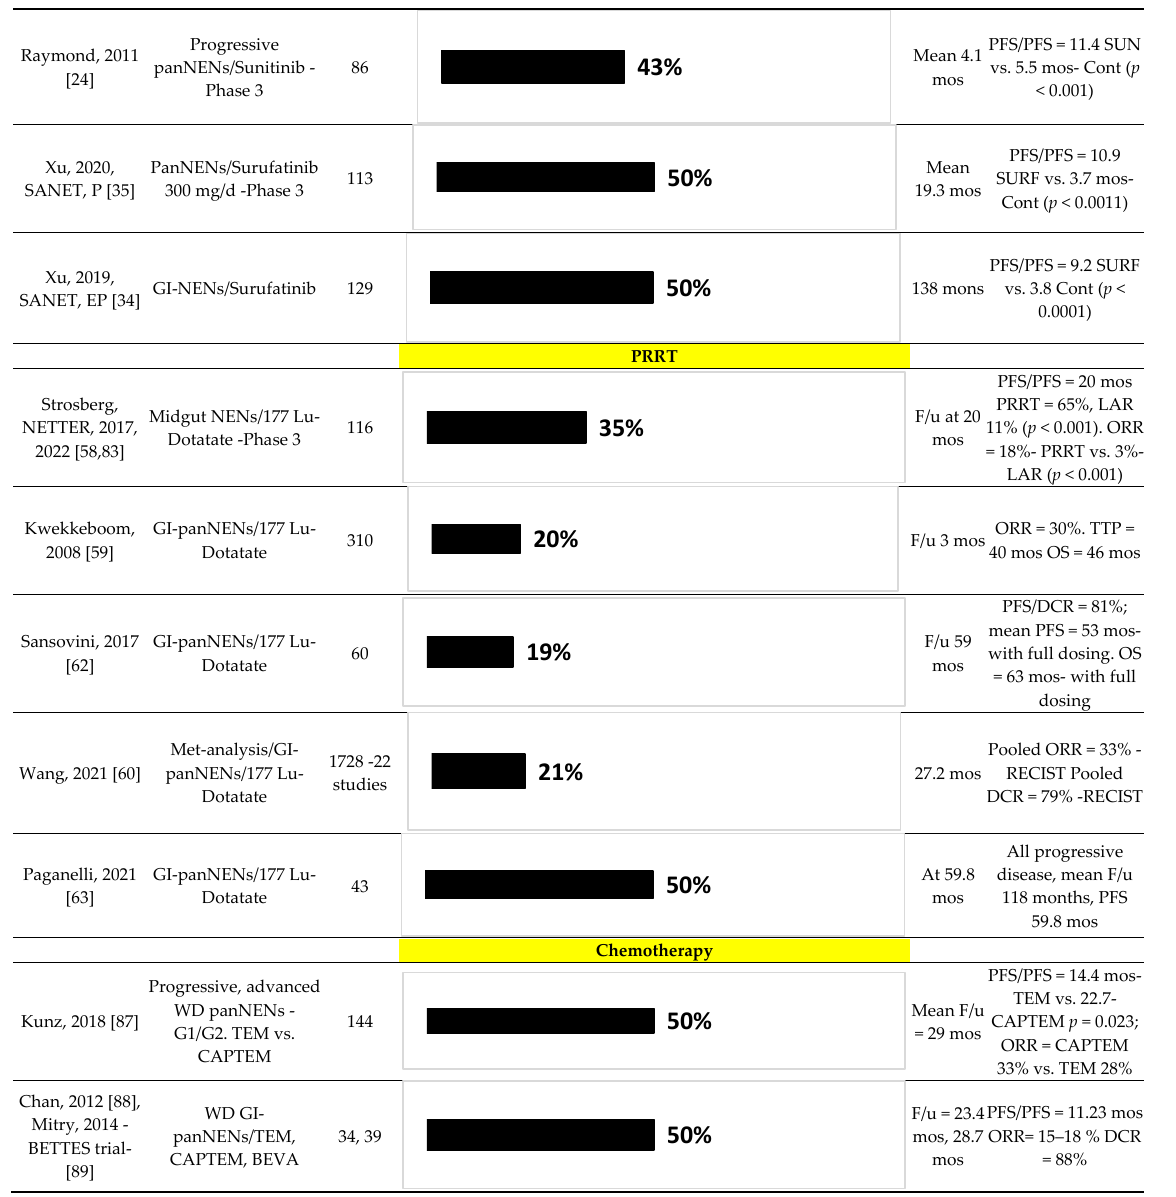
Figure 1. Resistance to various anti-tumor treatments of patients with advanced NENs from various selected studies ( [24,29,34,35,45,46,58–60,62,63,82–89]) . This figure only includes data from well differ-